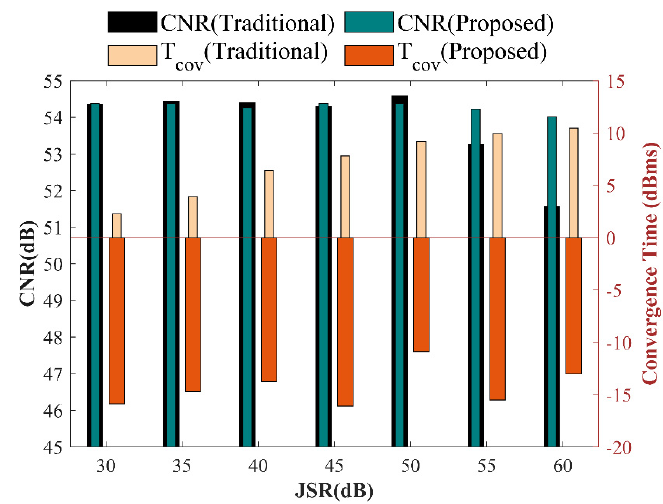
Figure 11. Performance comparison under scenarios with different interference power.